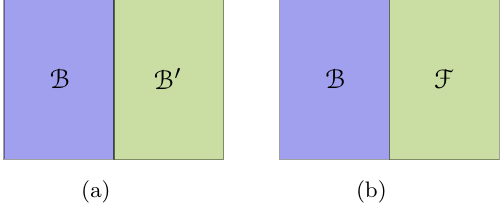
Figure 1 . Gapped domain walls between two bTOs (a) and between a bTO and an fTO